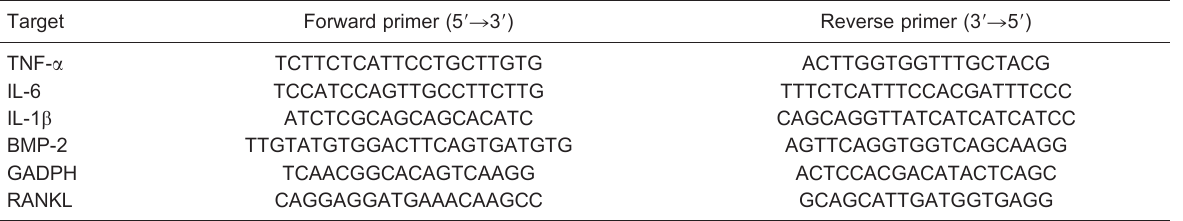
Table 1. Primers for real-time